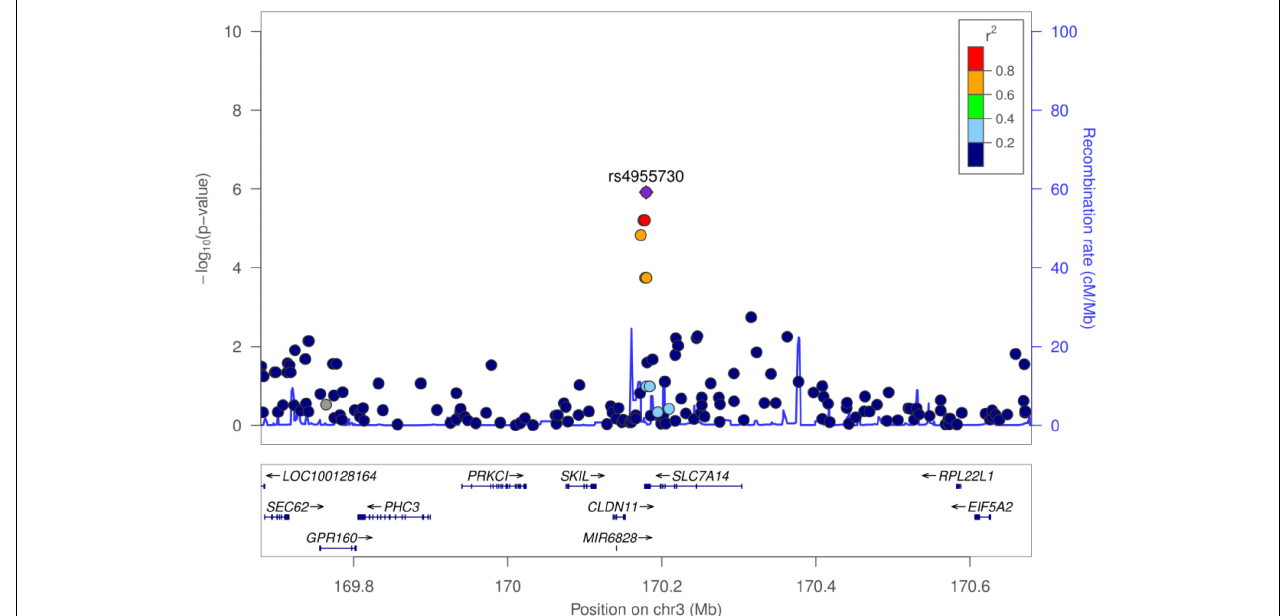
FIGURE 3 | Regional association plot of the SaIE susceptibility locus on chromosome 3. The y axis shows the P -values in –log10 scale for SNPs up- and downstream of the sentinel SNP (purple dot). The extent of linkage disequilibrium (LD; r 2 values) for all SNPs with the sentinel SNP is indicated by colors. The location of genes is shown at the bottom. TABLE 2 | Genetic variants suggestively associated with S. aureus infective endocarditis in the GWAS of 67 cases and 72 controls of the discovery VIRSTA cohort.